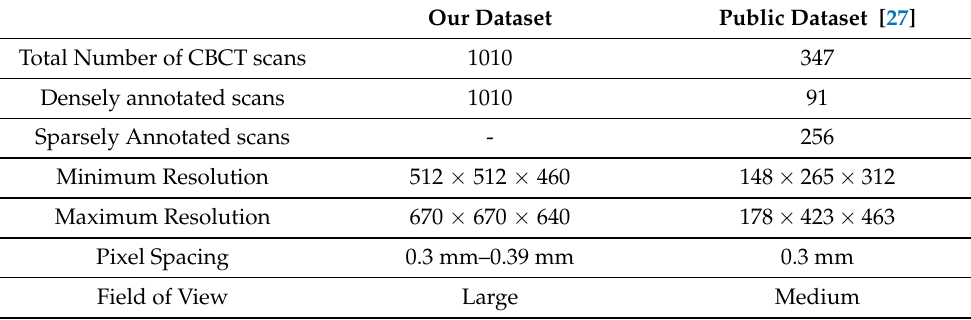
Table 2. Comparison of our dataset with public dataset.